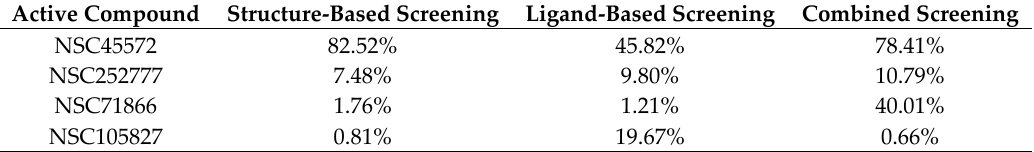
Table 2. The screening percentage or fraction of the NCI Diversity Set-II collection needed to be experimentally evaluated for recovering each of the 4 most potent CK1 inhibitors. Values were determined on the basis of ranking achieved by the optimally performing structure-based, ligand- based, and combined screening methods, as they are individually described in Sections 2.4, 2.5 and 2.6, respectively. More specifically, all values have been calculated by dividing the rank of each active compound by the total number of entries in each of the described screening calculations and subsequently determining the corresponding